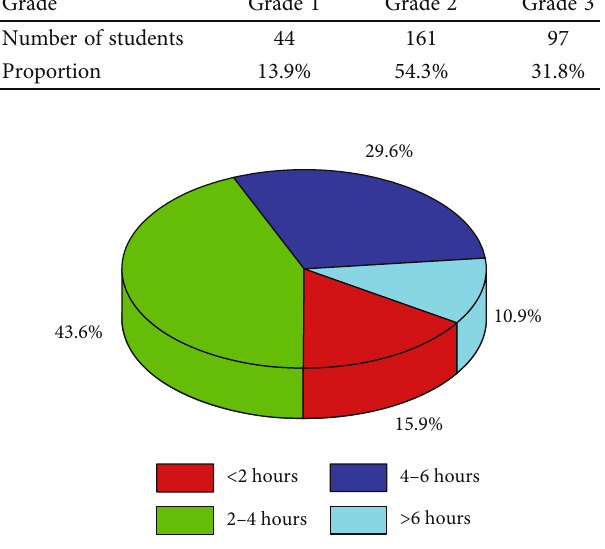
Figure 2: Survey of students ’ Internet access. Table 3: Questionnaire on students ’ network operation